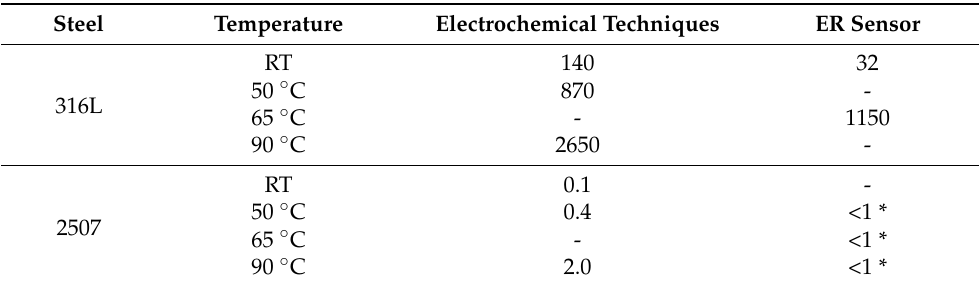
Table 4. Comparison of corrosion rates ( µ m/year) in the direction normal to the rolling direction for the grade 316L and grade 2507 steel, obtained with electrochemical techniques and ER sensors. Steel